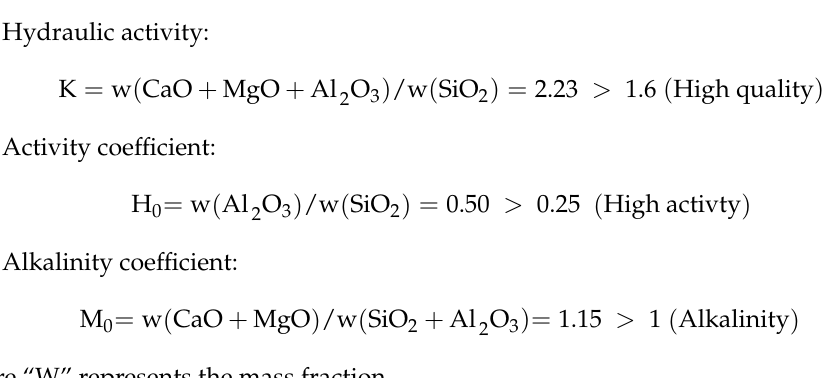
Figure 2. XRD spectra of ( a ) BFS and ( b ) FGDG.